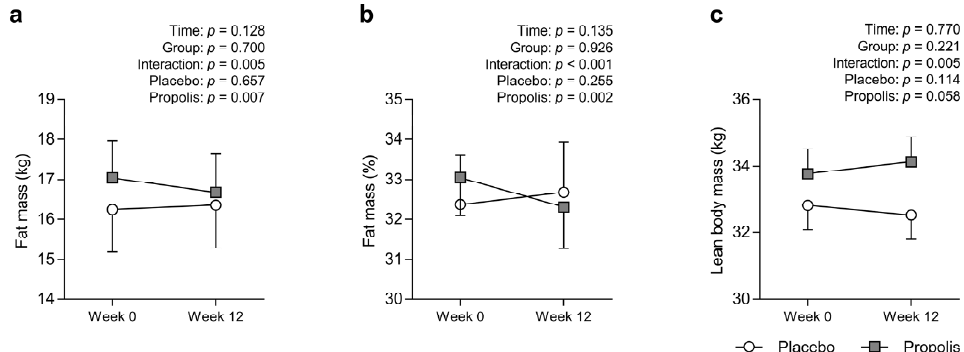
Figure 2. Absolute fat mass ( a ), relative fat mass ( b ), and absolute lean body mass ( c ), with the exception of the head in the placebo (white) and propolis (gray) groups. Values were presented as mean ± standard error of the mean. Variables were analyzed via two-factor repeated-measures analysis of variance, with time (week 0 vs. 12) and group (placebo vs. propolis) as factors. A p value of <0.05 was considered significant. If there was a significant time × group interaction, post hoc analyses with Bonferroni correction were performed to identify significant within-group effects.